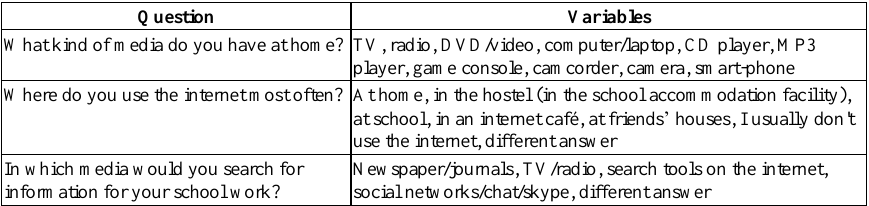
Table 3. Description of the data from the first questionnaire section – technical aids Question Variables